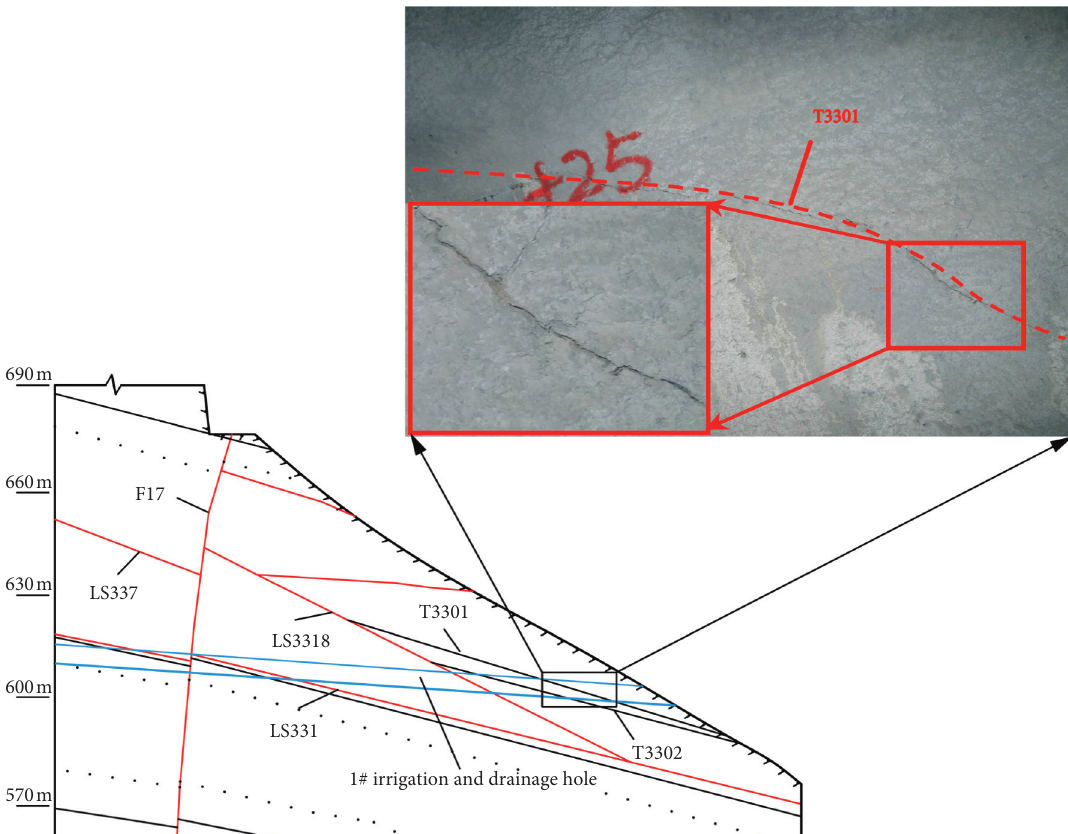
Figure 14: The location and photograph of T3301